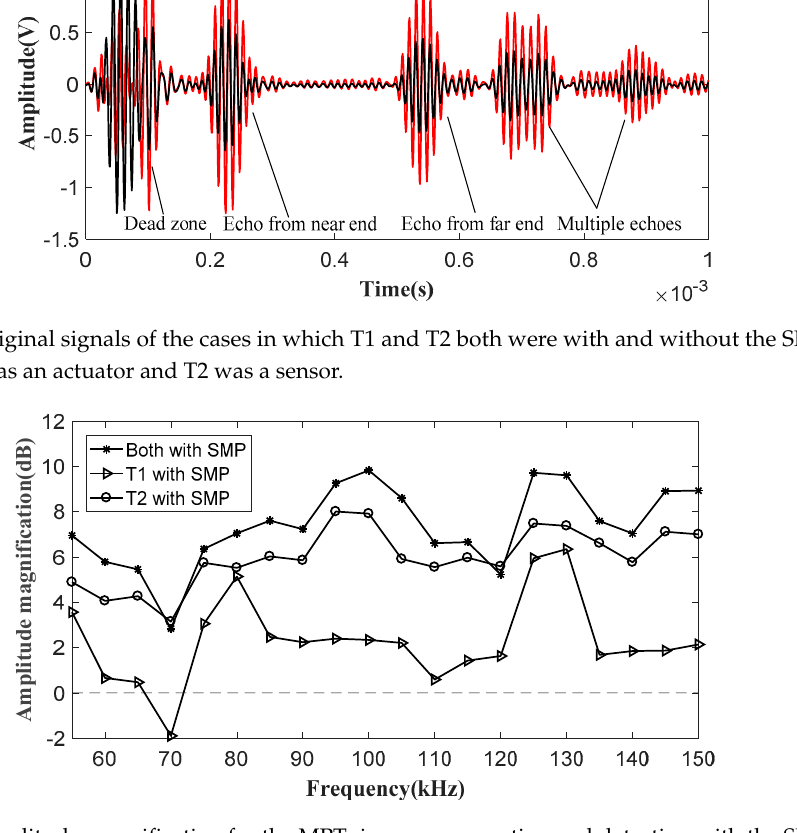
Figure 15. Amplitude magnification for the MPTs in wave generation and detection with the SMPs at different frequencies. T1 was an actuator and T2 was a sensor.